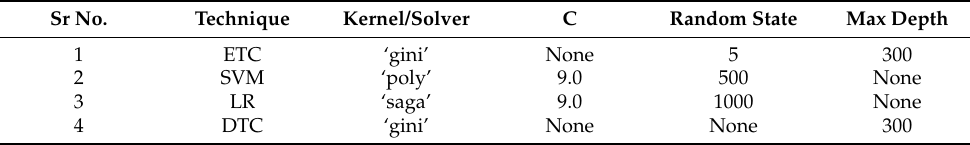
Table 2. The hyperparameter configuration parameters of all employed approaches. Sr